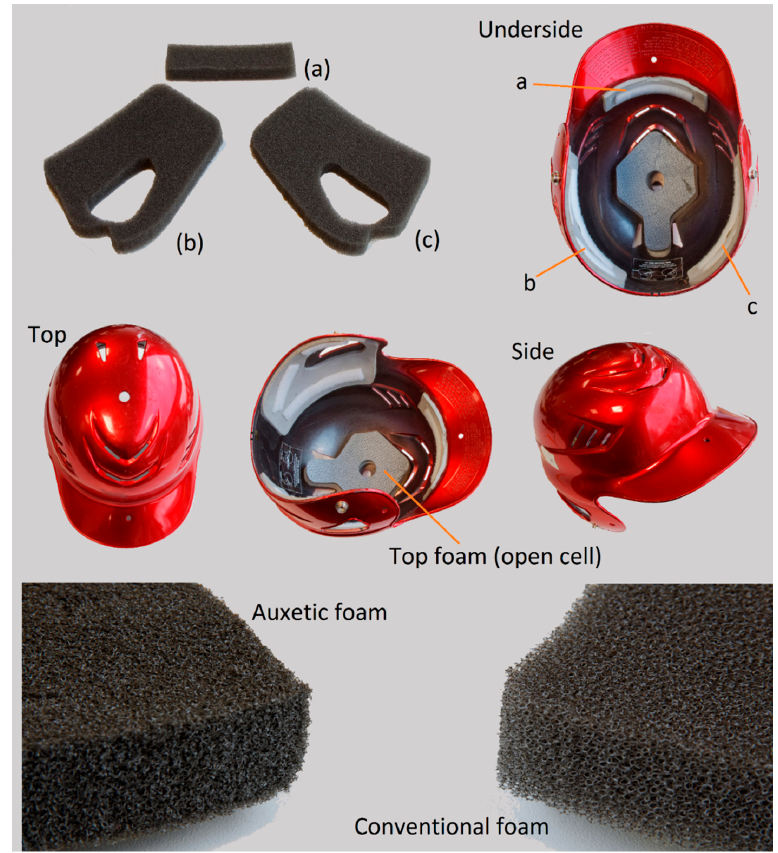
Figure 1. Foam inserts: ( a ) forehead, ( b ) right side, and ( c ) left side and views of the helmet showing native closed cell EVA foam and the top open cell foam in situ along with markers showing where inserts are placed. Also showing the foam structures for the auxetic ( bottom left ) and conventional ( bottom right ).